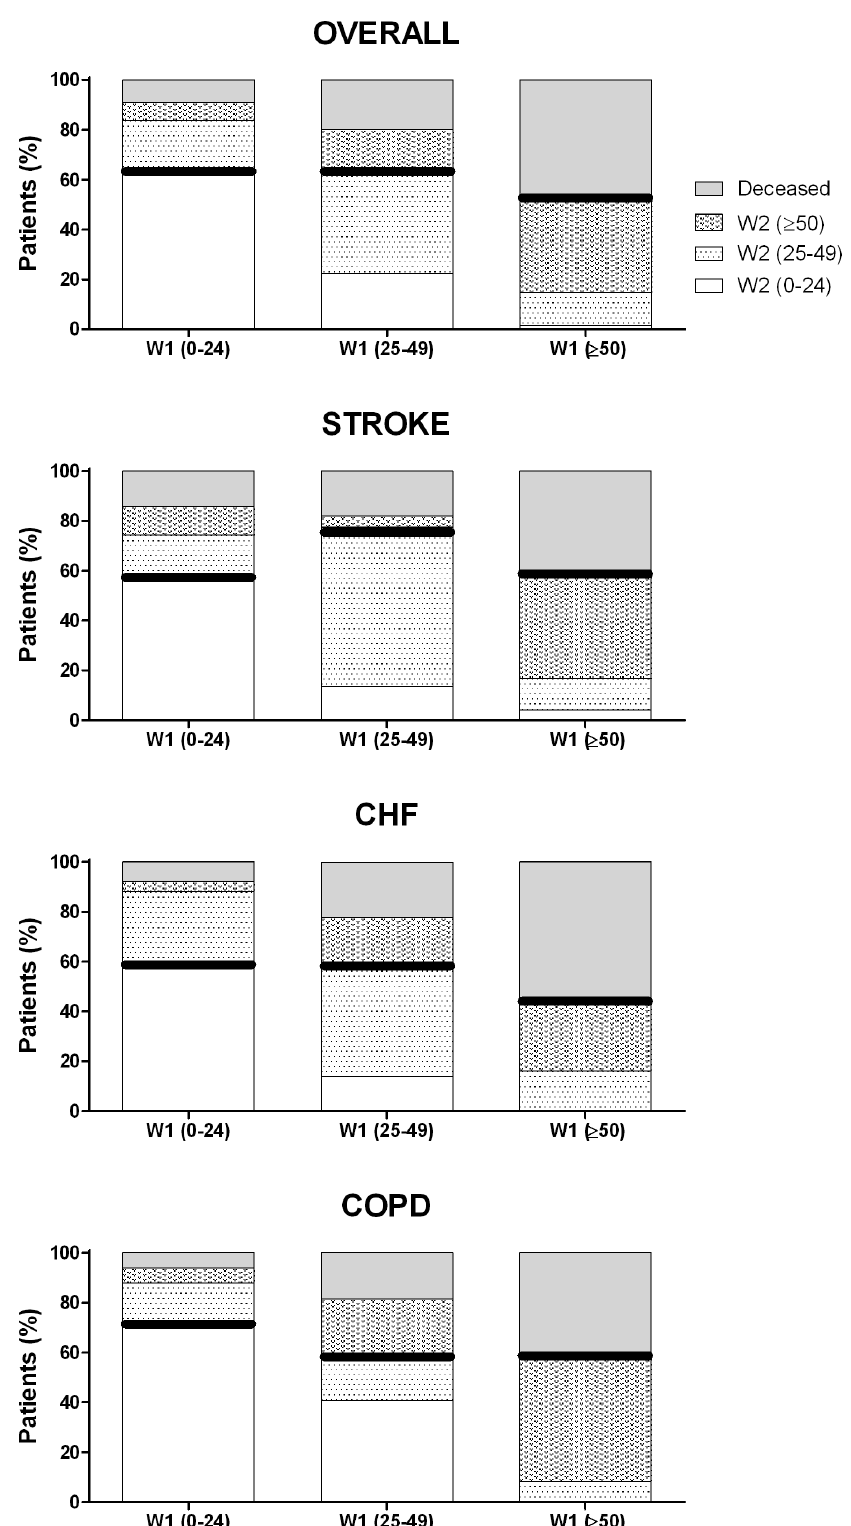
Figure 3. Distribution of outcomes (disability levels and death) at end of follow-up for each of three baseline disability levels, overall and by diagnostic group. Fragments above solid, thick bands indicate worsening with respect to baseline values. doi: 10.1371/journal.pone.0077482.g003 PLOS ONE |